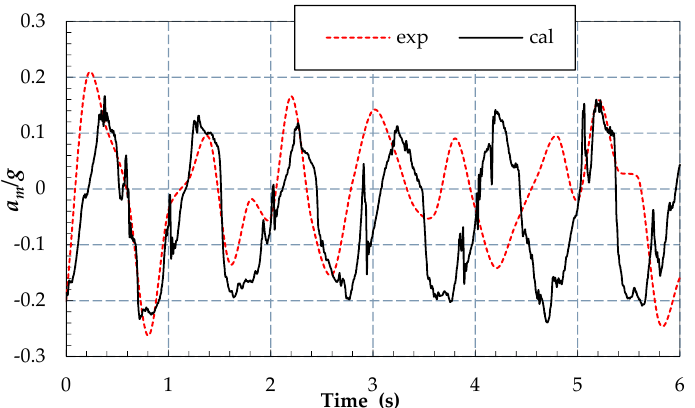
Figure 23. Cycle oscillation pitch contrast curves for the operation condition of λ = 7 m, F n = 0.99.